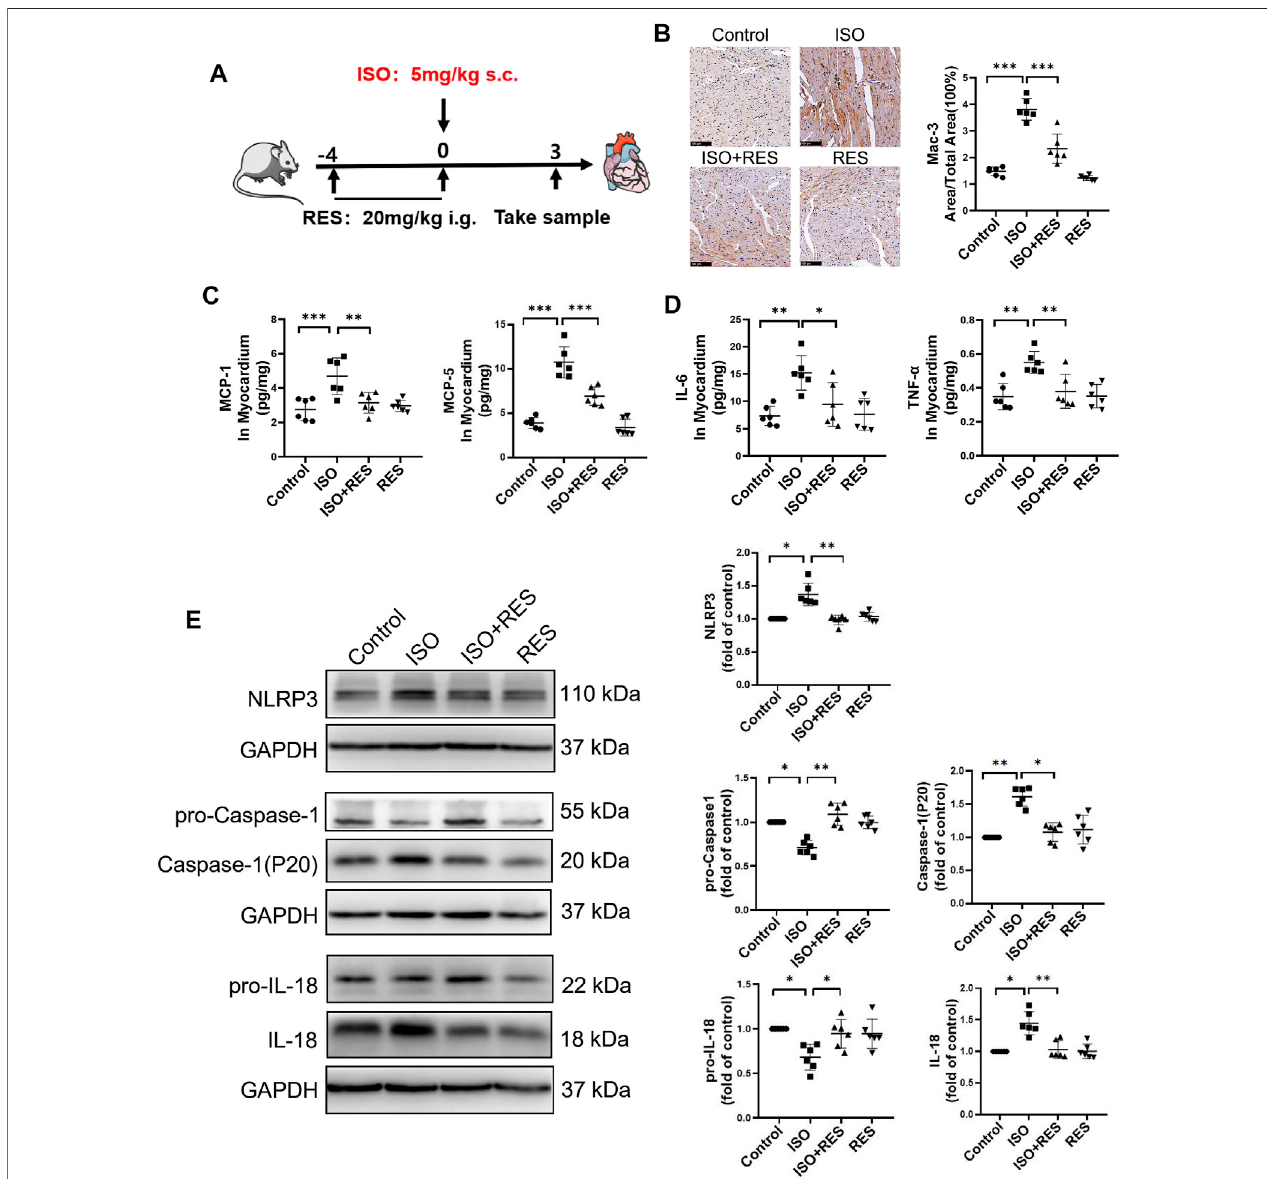
· FIGURE 6 | Resveratrol alleviated isoproterenol-induced cardiac in fl ammation and activation of the NLRP3 in fl ammasome in mice. Ten-week-old male C57BL/6J mice were administered resveratrol (20 mg/(kg d) body weight, intragastrically) for 3 days prior to isoproterenol (5 mg/kg body weight, subcutaneously) treatment. (A) Mode in mice. (B) Representative images and quanti fi cation of immunostaining for Mac-3 (a macrophage marker) in the heart on the third day after isoproterenol treatment( n =6;scalebars:100 μ m). (C – D) Concentrationsofindicativechemokines(MCP-1,MCP-5)andpro-in fl ammatorycytokines(IL-6andTNF- α )onthe3rd day after ISO treatment as measured by ELISA ( n = 6). (E) Protein levels of NLRP3, pro-caspase-1, caspase-1(P20), pro-IL-18 and cleaved IL-18 were detected by Western blotting. * p < 0.05; ** p < 0.01; *** p < 0.001; RES, Resveratrol; ISO, isoproterenol. Data are mean ± SD (one-way ANOVA with Tukey ’ s post-hoc test or Kruskal – Wallis ANOVA with post-hoc Dunn ’ s multiple comparison